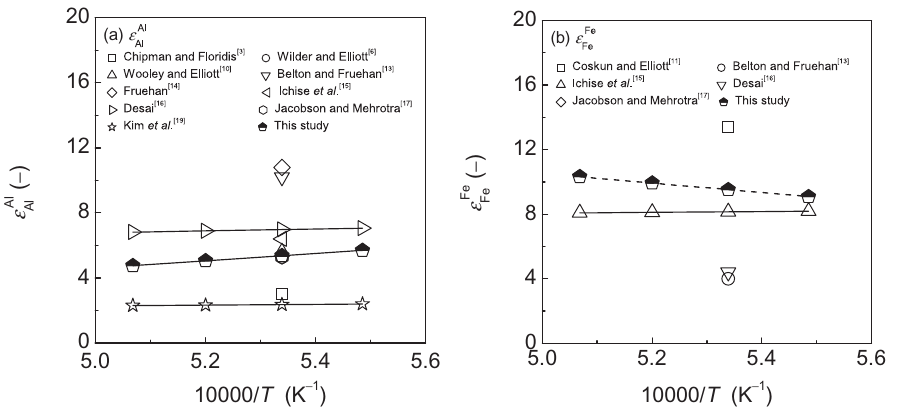
of Al (a) and ε Fe of Fe (b) by various researchers with obtained Fe Al